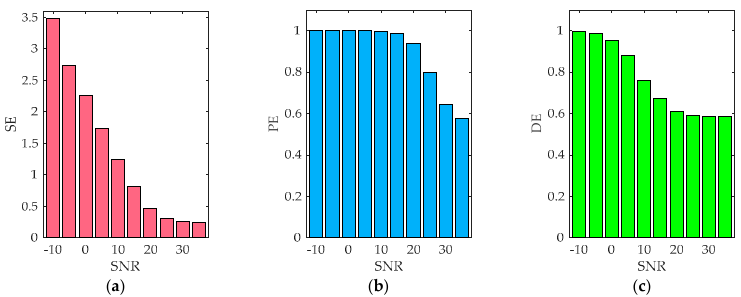
Figure 4. Time-domain waveforms of simulated signals with different signal-to-noise ratios (SNRs).